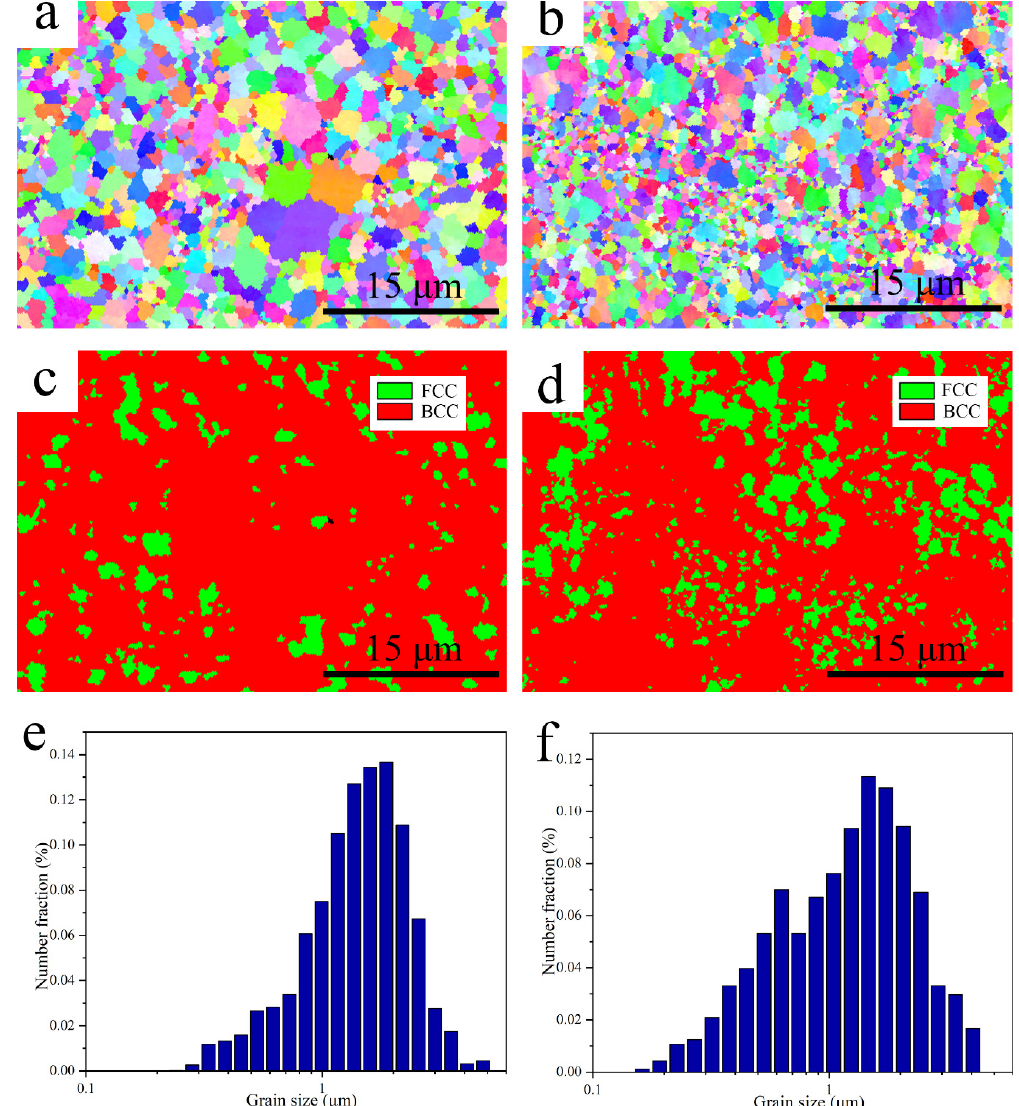
Figure 5. Inverse pole figure (IPF) maps of the SPSed ( a ) HEA and ( b ) HEA-10TiC, phase composition of the SPSed ( c ) HEA and ( d ) HEA-10TiC, and grain size of the SPSed ( e ) HEA and ( f ) HEA-10TiC.